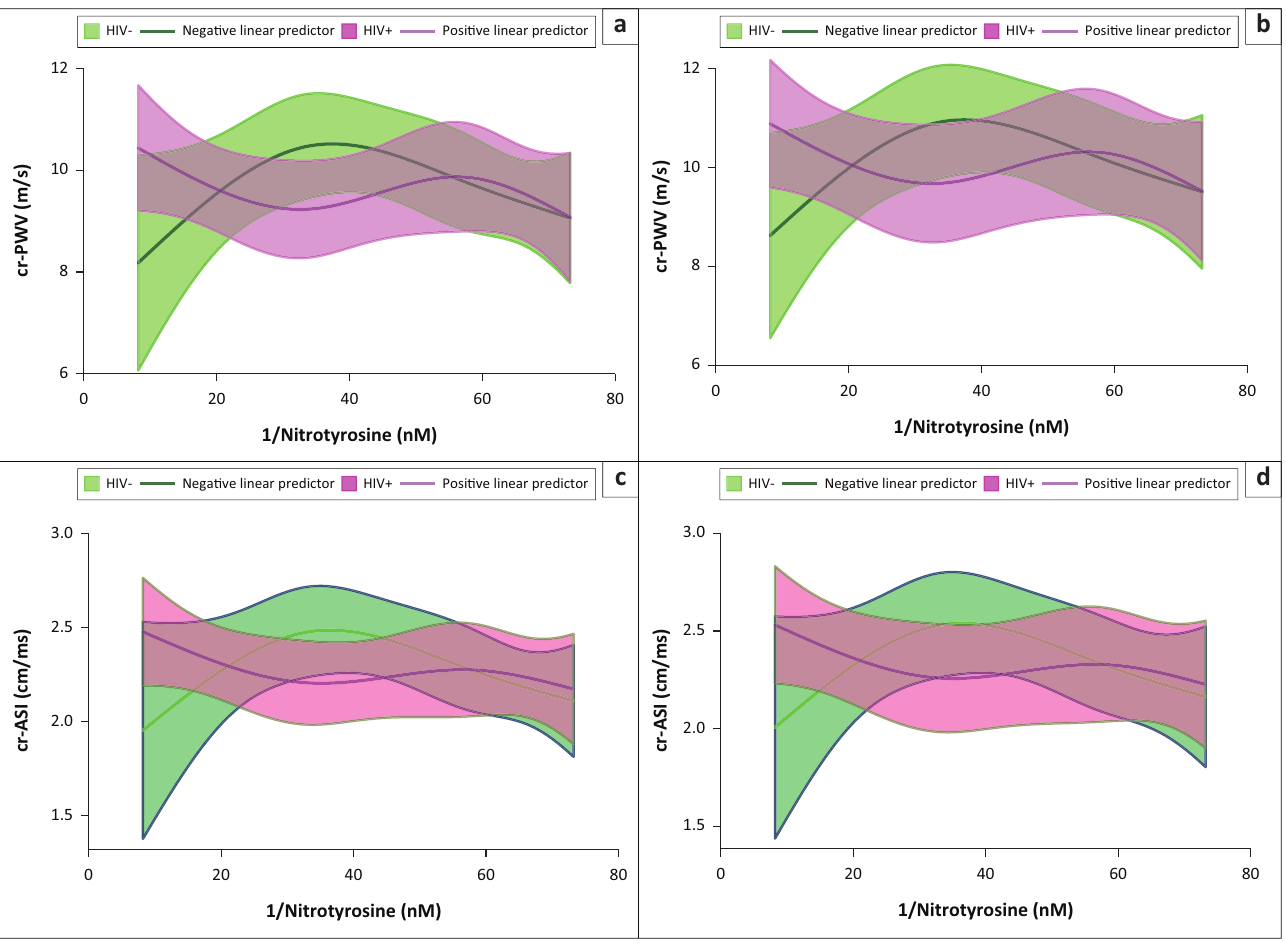
FIGURE 1 : Plasma nitrotyrosine levels predicting endothelial dysfunction (carotid–radial pulse wave velocity [a and b] and carotid–radial arterial stiffness index [c and d]) among individuals without HIV and those with HIV. Other covariates have been set at their medians: age, 32 years old; hip circumference, 93 cm; body fat mass, 24 kg; diastolic blood pressure, 78 mmHg; systolic blood pressure, 121 mmHg; waist circumference, 73 cm. Values for female participants have been plotted on a and c and those for male participants on b and